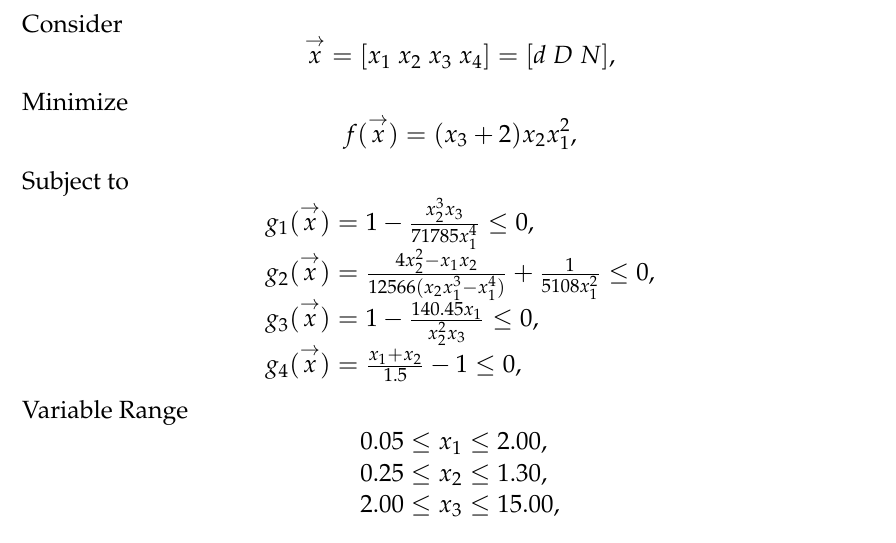
Figure 9. The tension/compression spring design problem: 3D model diagram ( left ) and structural parameters ( right ).